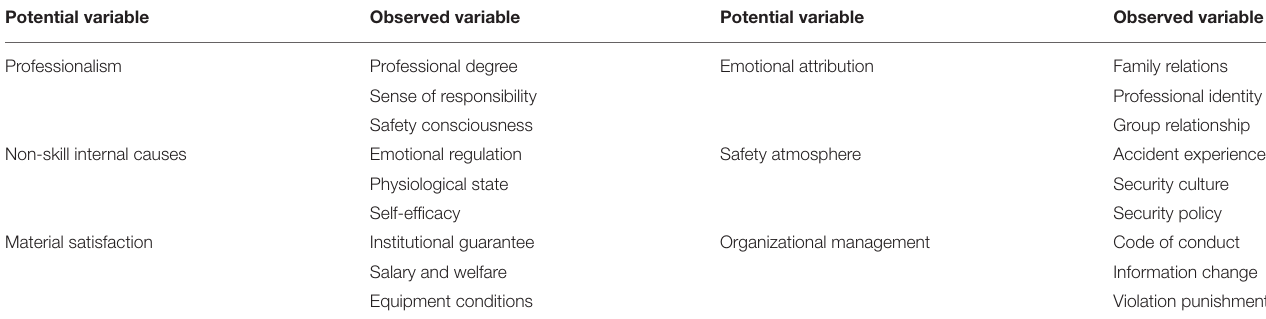
TABLE 1 | Potential and observed variables